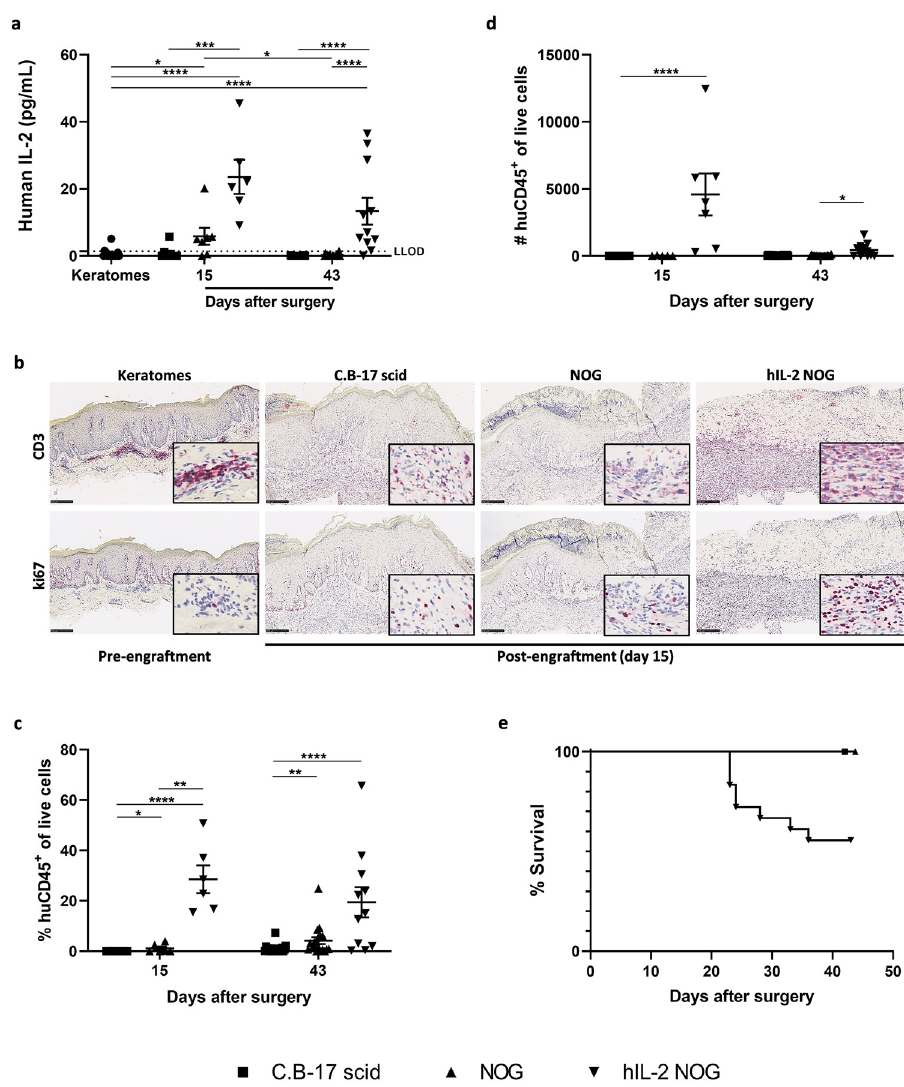
Fig 1. Human IL-2 protein levels in the grafts, human immune cells in grafts and lymph nodes and survival of hIL-2 NOG mice. Keratomes from six psoriasis vulgaris patients were included in the study. The number of mice in each group were on day 15: C.B-17 scid n = 8; NOG n = 7; hIL2-NOG n = 6 and on day 43: C.B-17 scid n = 20; NOG n = 20; hIL2-NOG n = 11. (a) Protein levels of human IL-2 were analyzed in keratome (three biopsies from each keratome, n = 18) and graft lysates by the MSD platform (LLOD is lower limit of detection). (b) Immunohistochemical staining with anti-human CD3 and anti-human ki67 on day 15. Representative slides are shown. The bar equals to 250 μ m and slides are shown in a 10X magnification with a 20X magnification picture inserted in the lower right corner. (c) Percent and (d) number of human CD45 + of live cells were analyzed in axillary lymph node cell suspensions by flow cytometry on day 15 and 43. (e) Survival of mice over time after engraftment of psoriasis skin. The survival curves of C.B-17 scid and NOG mice are placed on top of each other, but marked separately ( & and ▲ , respectively).